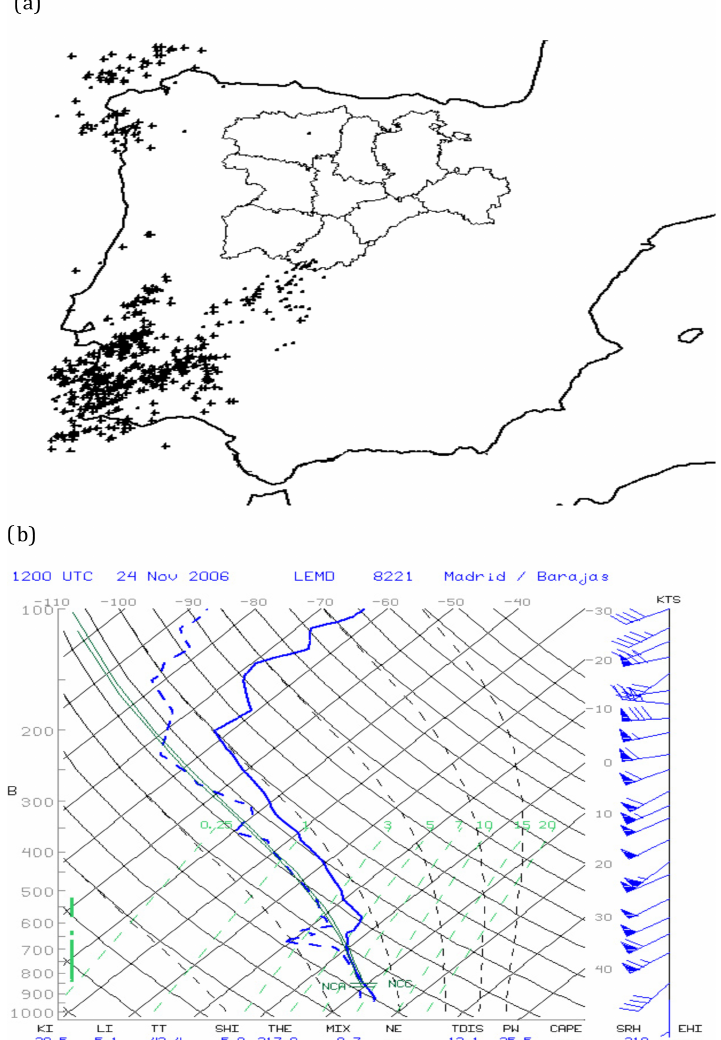
Figure 5. (a) Cloud-to-ground lightning flashes detected ( + positive flashes) on 24 November over the Iberian Peninsula, and (b) Madrid sounding (40 ◦ 27 (cid:48) N, 3 ◦ 43W) on 24 November at